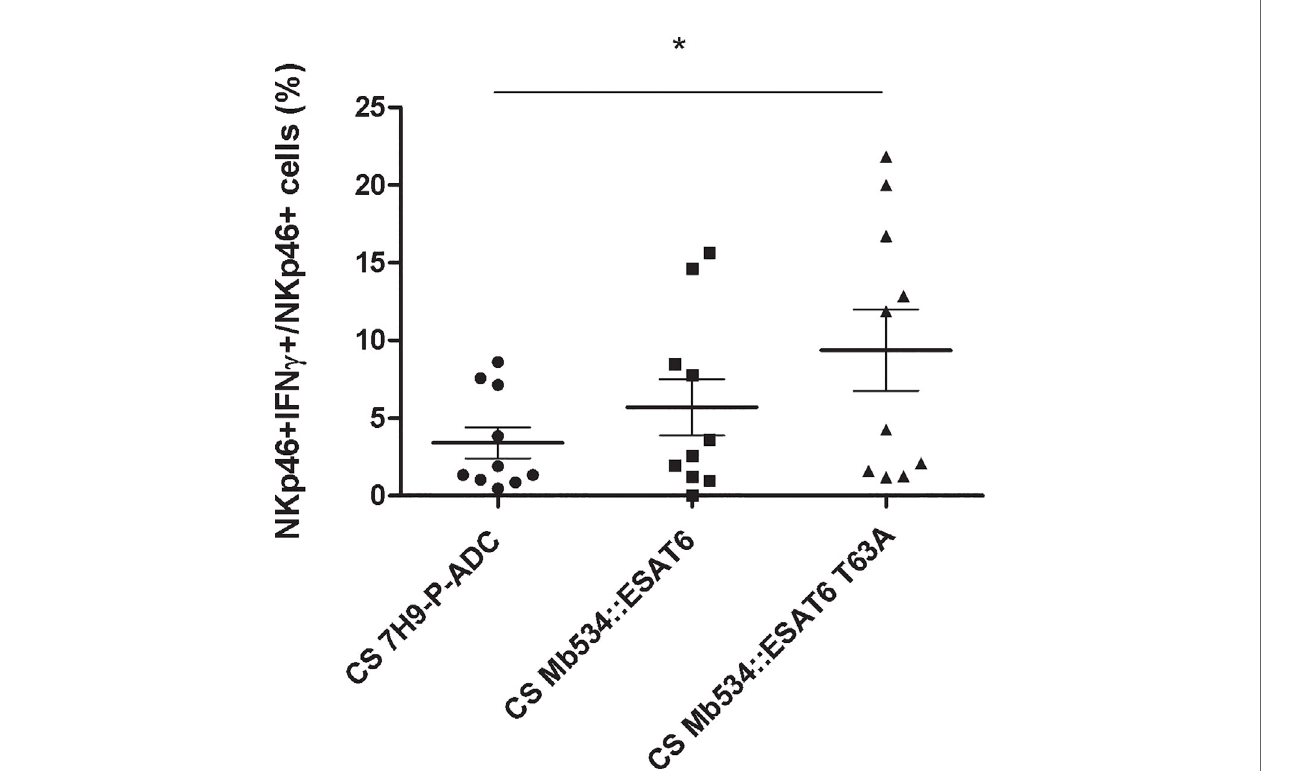
FIGURE 8 | Percentages of NKp46+ IFN- g + in co-cultures from ten calves (N=10) stimulated with 10 mg of the lyophilized culture supernatants (CS) from the recombinant versions of Mb534 expressing wild type ESAT-6 (Mb534::ESAT6) and the Mb04-303 mutant version of ESAT-6 (Mb534::ESAT6 T63A). Lyophilized culture medium alone (10 mg) was used as a negative control (CS 7H9-P-ADC). For each animal sample and condition tested, a single cell well was analyzed. Each symbol represents an individual animal; horizontal lines represent mean values and whiskers SEM. The results are expressed as IFN- g + cells in total NKp46 + population (*signi fi cant differences p < 0.05 by Friedman test with Dunn ’ s post-test for multiple comparisons).